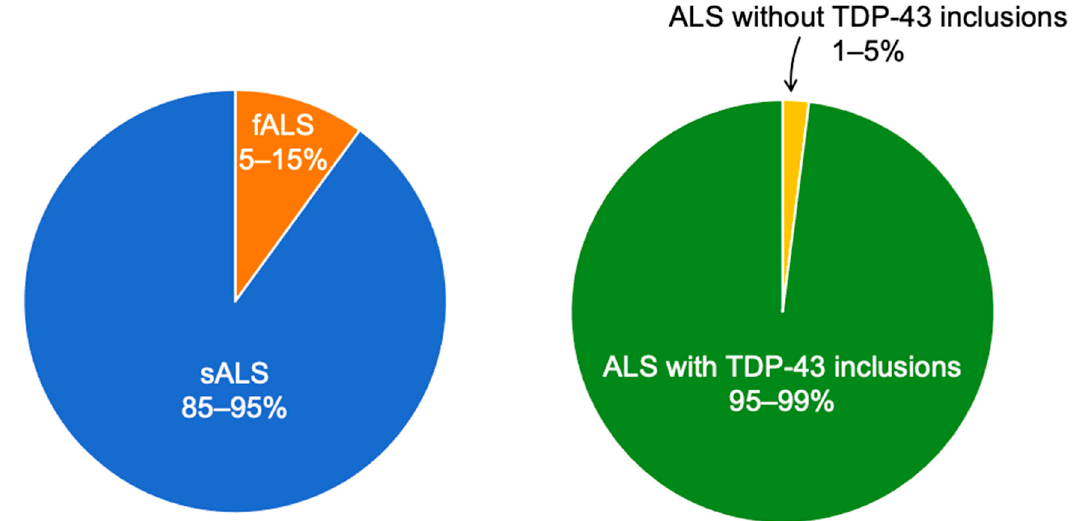
Figure 1. Left: ALS is classified into sporadic (sALS) and familial (fALS) cases [1]. Right: inclusions of the TDP-43 protein are found in the majority of ALS cases [9]. Original drawing by L.K.